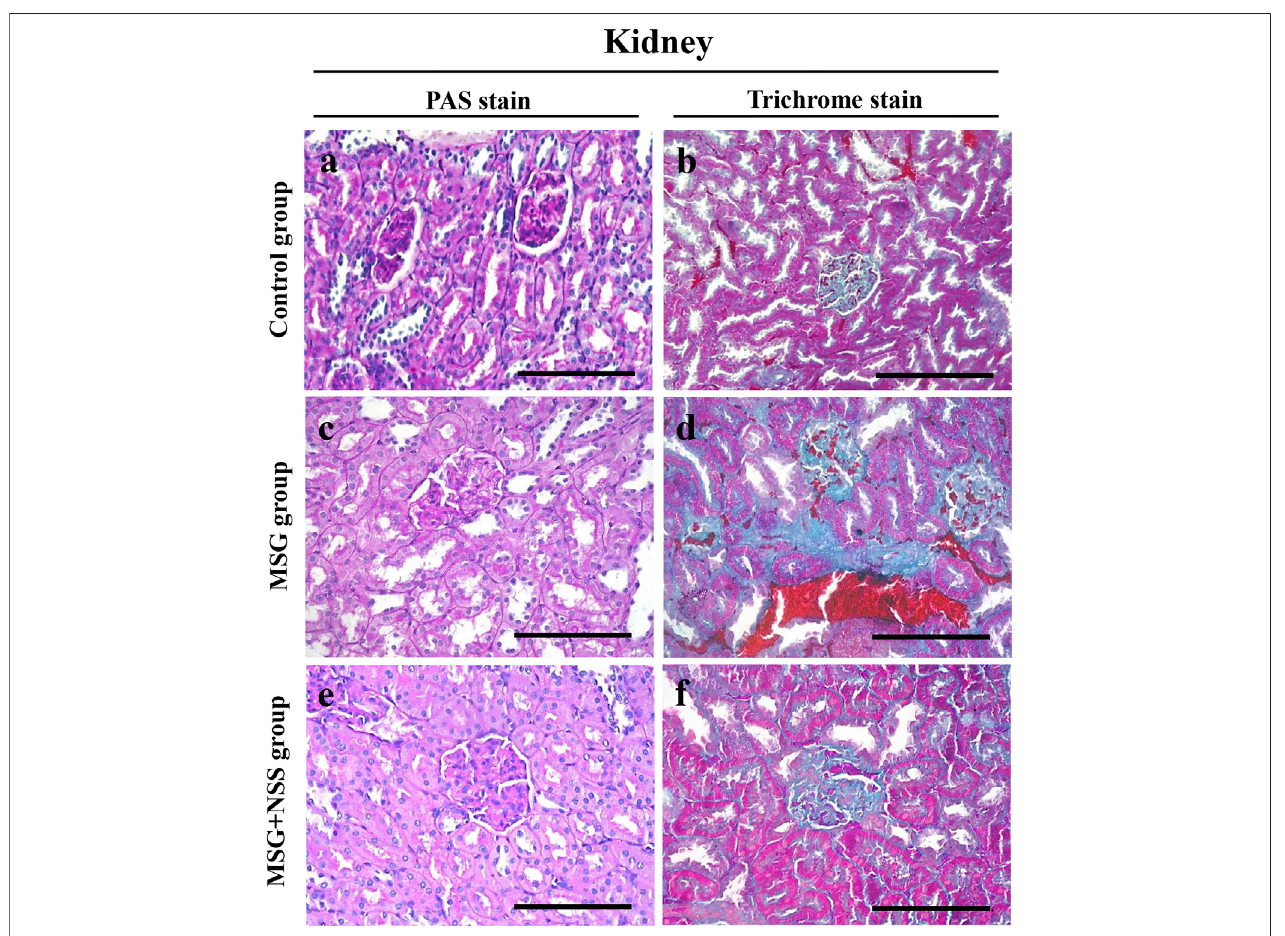
FIGURE2| Evaluationoftheglycoproteinandcollagen fi bersinthekidneyusingPASandCrossmon ’ strichromestains,respectively, (A,B) Kidneyfromthecontrol group showednormal glomerulus and tubules (A) and normal collagen fi bers amount and distribution (B) (C,D) Kidneyfrom the MSG-treated group showed glomerular fi brosis, loss of the tubular brush border, and deposition of intratubular protein casts (C) and dense collagen fi bers deposition (D) (E,F) kidney from the MSG + NSS- treatedgroupshowedminimalglomerularandtubulardamage (E) andimprovedcollagen fi bersdeposition (F) .PASandCrossmon ’ strichromestain.Scalebarsin panels (A – F) = 50